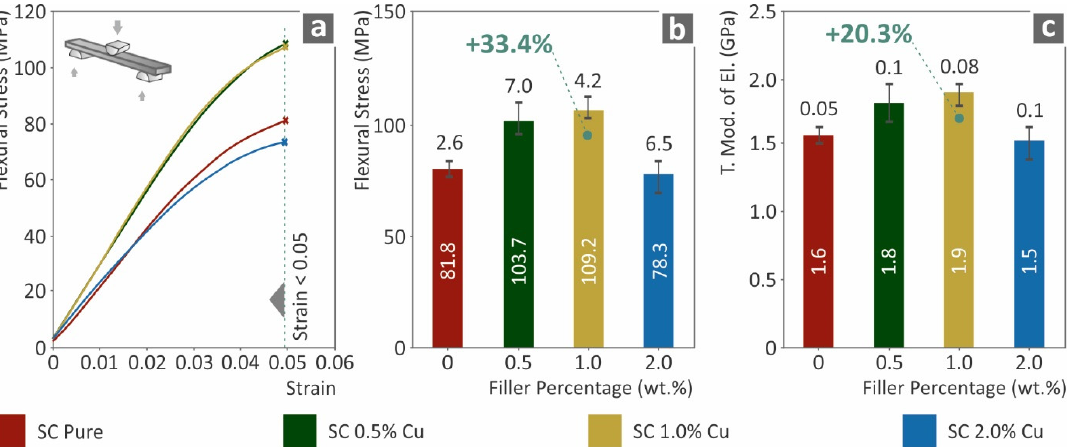
Figure 4. ( a ) Typical flexural stress (MPa) to strain (mm/mm) curve, ( b ) Flexural stress (MPa) at 5.0% strain (following the standard instructions) to filler loading (wt.%), ( c ) flexural elastic modulus (MPa) to filler ratio (wt.%).